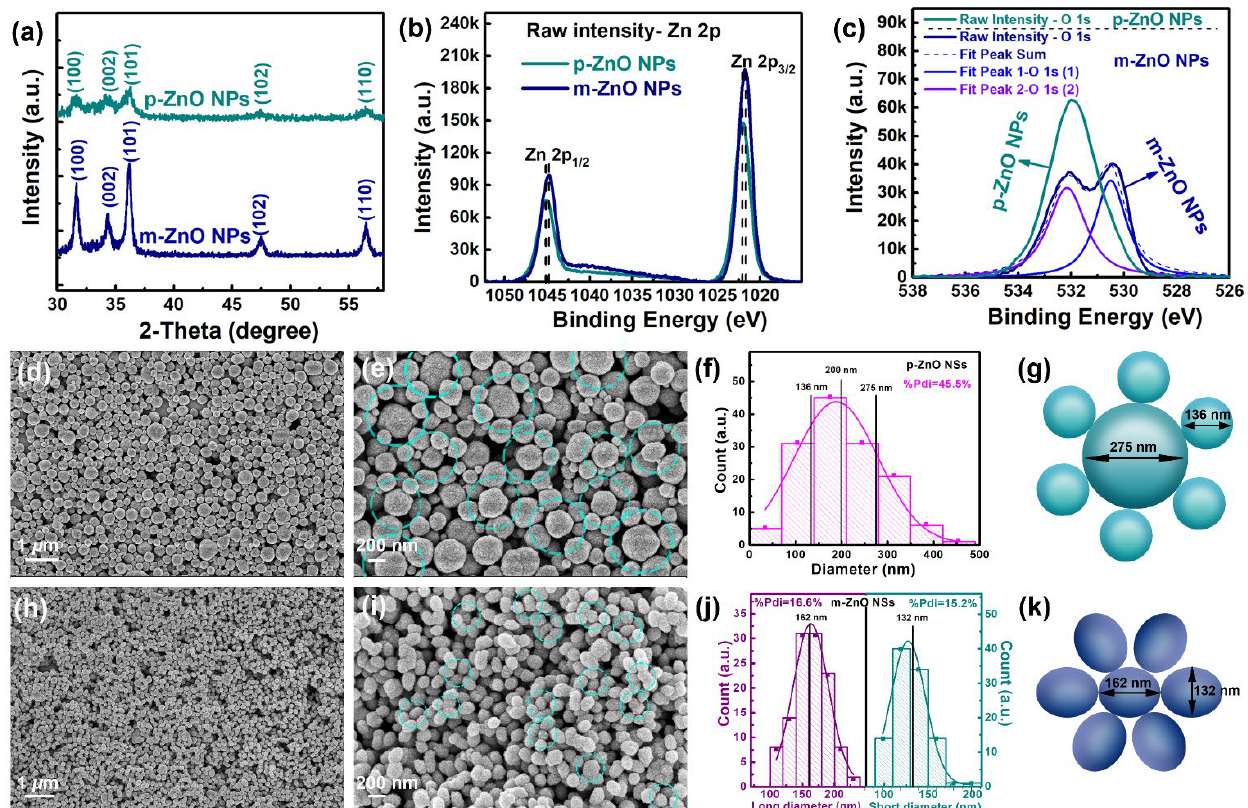
Figure 2. XRD spectra ( a ) and XPS spectra of ( b ) Zn 2p and ( c ) O 1s electron regions for the p-ZnO NSs and the m-ZnO NSs. SEM images of p-ZnO NSs ( d , e ) and m-ZnO NSs ( h , i ). Statistical histograms for the diameters of the p-ZnO NSs ( f ) and the m-ZnO NSs ( j ). Schematic diagram of p-ZnO NSs ( g ) and the m-ZnO NSs ( k ).